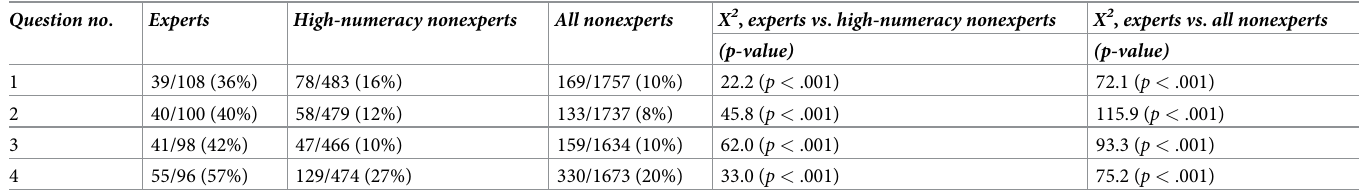
Table 2. Proportions of participants from each group (experts, high-numeracy nonexperts, and all nonexperts) for whom the outcome fell within their own 75% confidence intervals. Question no